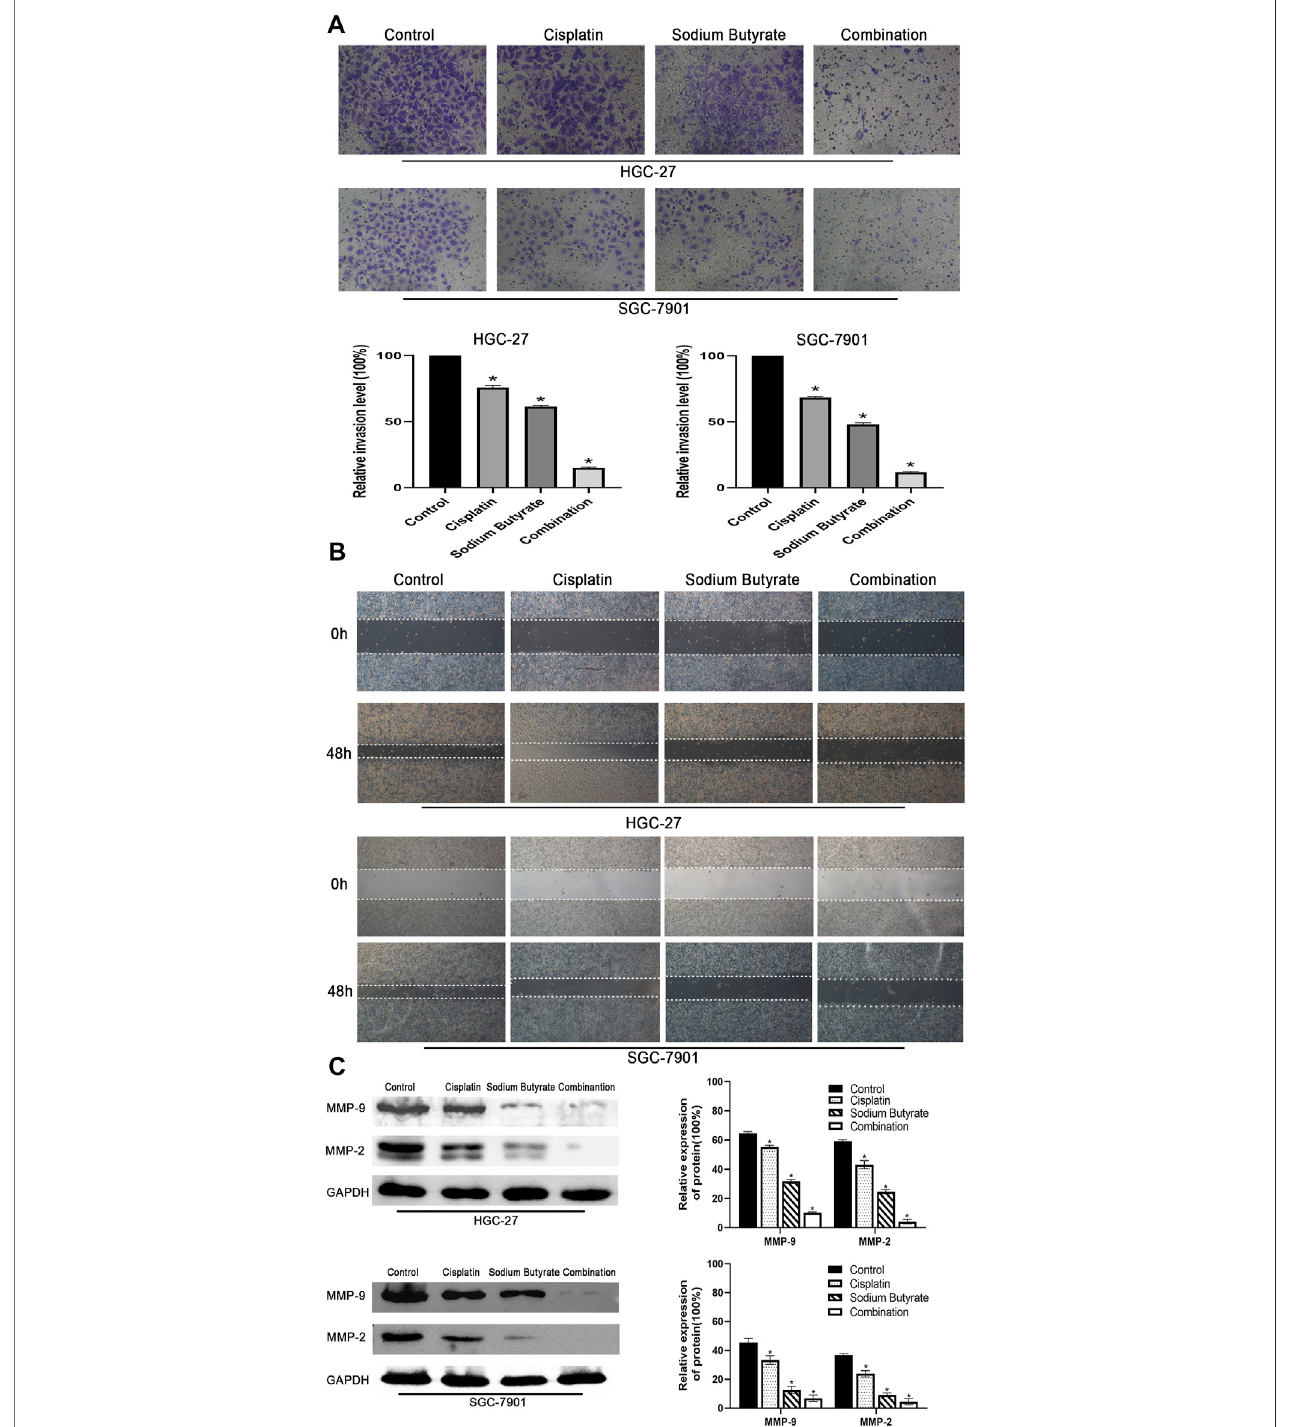
FIGURE2| Effects ofsodium butyrate and cisplatin ontheinvasionand migrationofGCcellsusing theTranswell invasionassayand thewound-healing assay. (A) Original magni fi cation: × 200. HGC-27 cells were treated with control, 4 µg/ml cisplatin, 10 mM soiudm butyrate, or 4 µg/ml cisplatin +10 mM sodium butyrate; SGC- 7901 cellsweretreatedwithcontrol,4 µg/mlcisplatin, 5 mM sodium butyrate, or4 µg/mlcisplatin +5 mMsodium butyrate. Quantitative analysisoftheaverageinvasive cell numbers in each group. * p < 0.05 vs the control group. (B) Cells were incubated with control, cisplatin, sodium butyrate, or cisplatin + sodium butyrate describedin (A) above. (C) ThelevelsofMMP-9andMMP-2weremeasuredusingwesternblottingandquantitativeanalysisoftheproteinswasperformed.* p < 0.05vs the control group. All the above data are the mean ± SD from an average of three experiments.